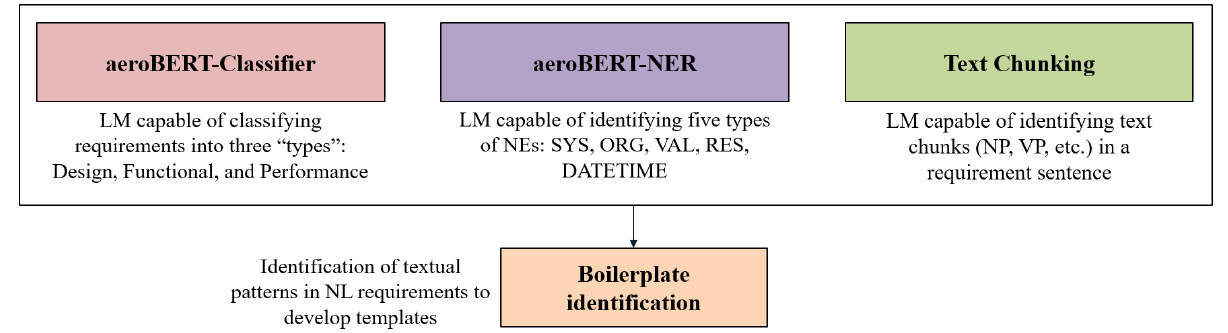
Figure 5. Pipeline for converting NL requirements to semi-machine-readable form enabling boiler- plate